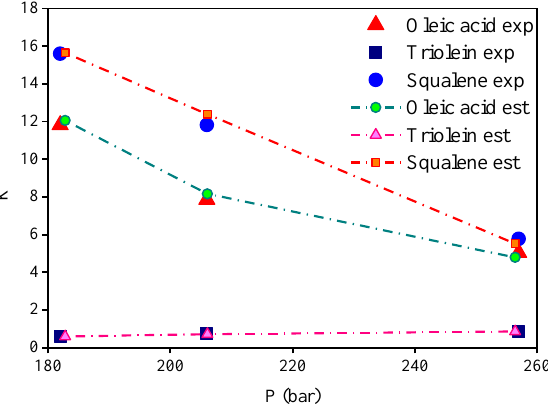
Figure 6. Experimental and estimated distribution coefficients K i , expressed in CO 2 -free basis, at 323 K with 2.9 [wt.%] of FFA.